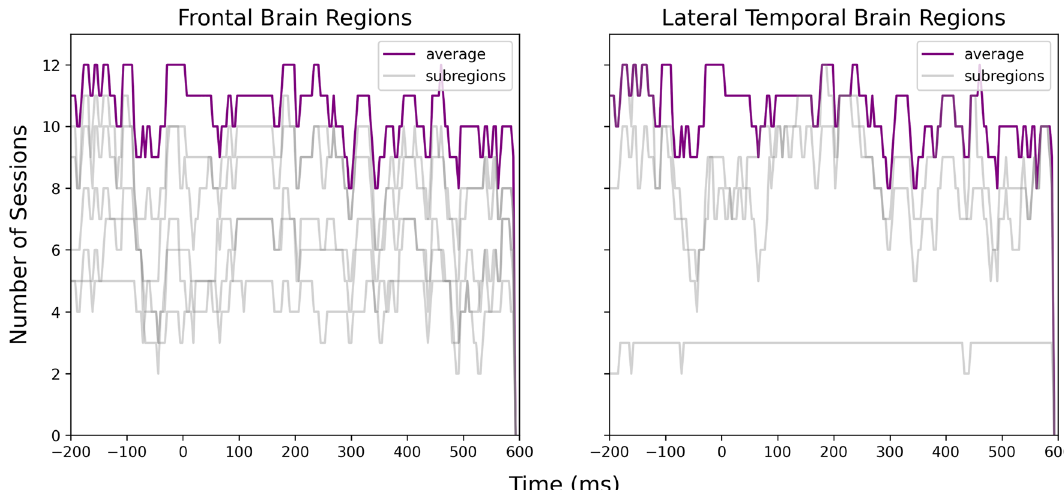
Figure 5. Number of sessions showing significant differences in the iEEG windows sampled around phrase boundaries and the reference windows at each time point. The purple lines were obtained by averaging all channels within the frontal and lateral temporal brain regions. The light gray lines were obtained by averaging the channels within sub-regions that contributed to the frontal and lateral temporal regions.